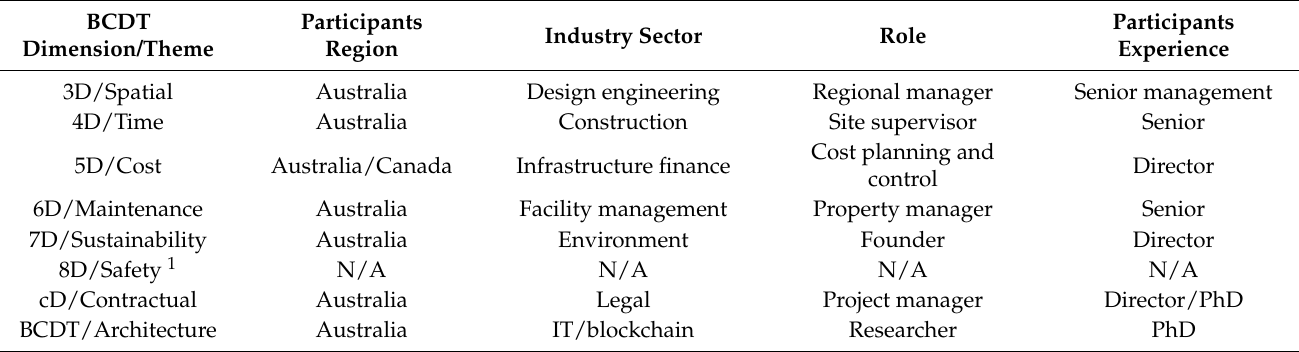
Table 1. Summary of interviewees’